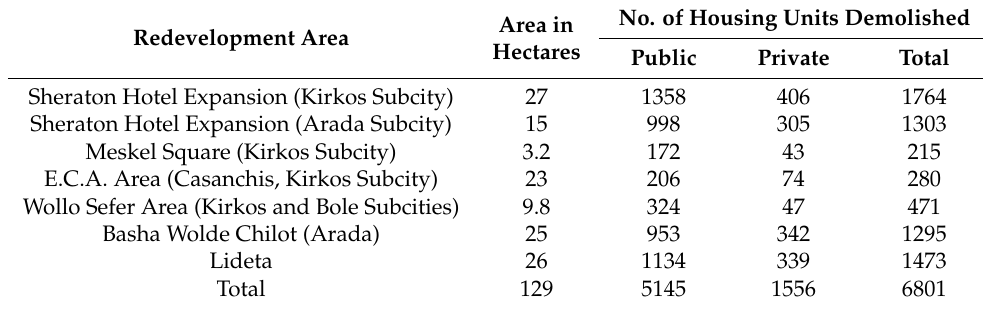
Table 4. Urban redevelopment and renewal projects in Addis Ababa.